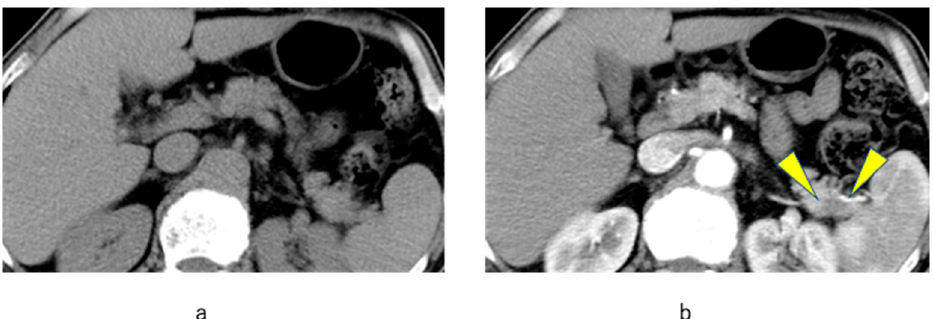
under the curve; CI, confidence interval. AUC: 0.955 (95% CI: 0.934, 0.976).